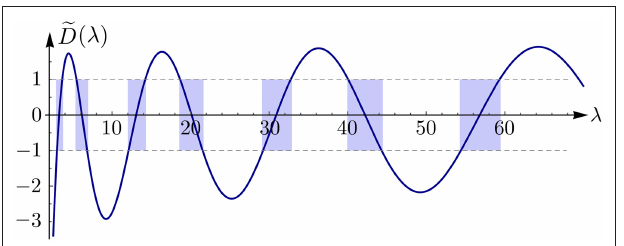
D (λ) from Example 3. e